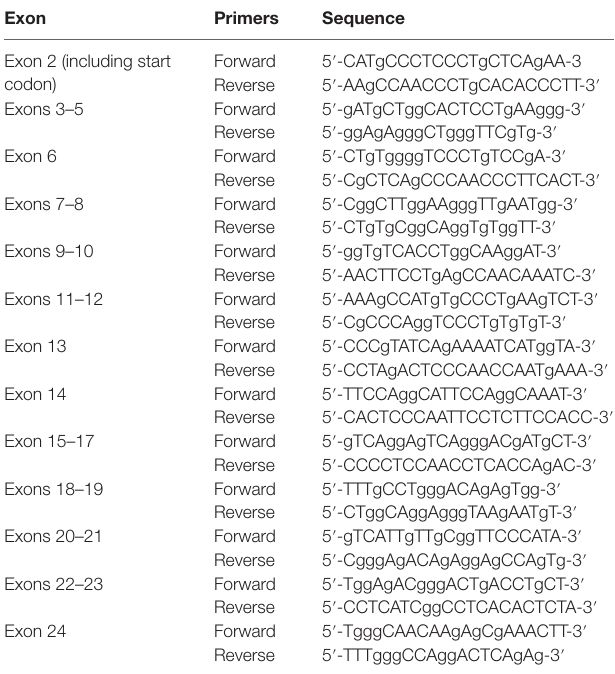
Table 2 | The sequences of primers used for the amplification of JAK3 . exon Primers sequence